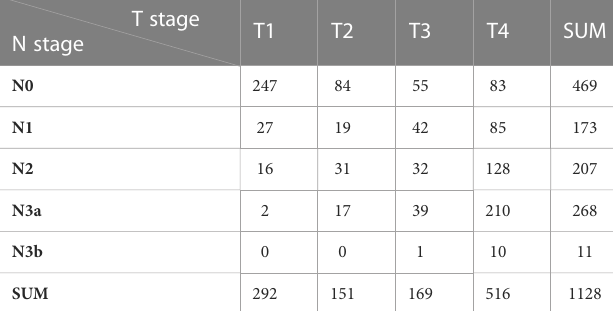
TABLE 3 The number of patients in each T/N